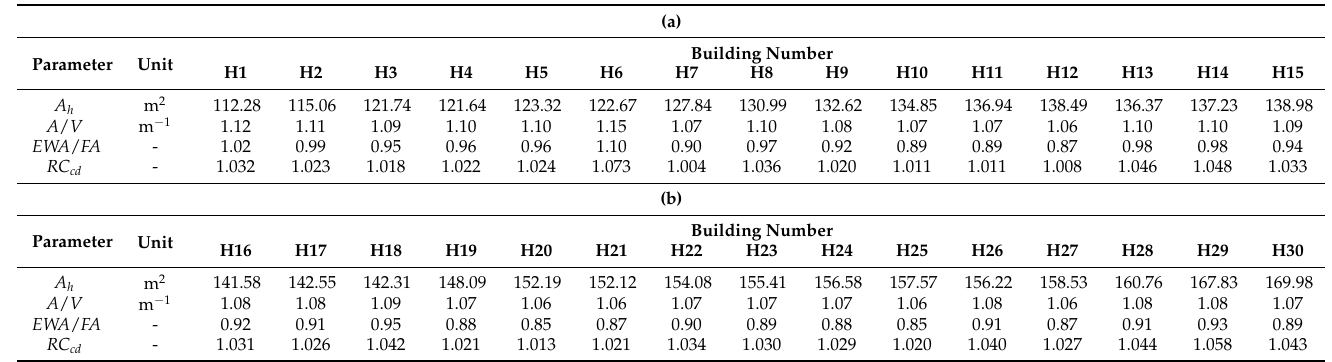
Table 1. ( a ) Basic geometrical parameters of the buildings H1–H15 [7]. ( b ) Basic geometrical parame- ters of the buildings H16–H30 [7].